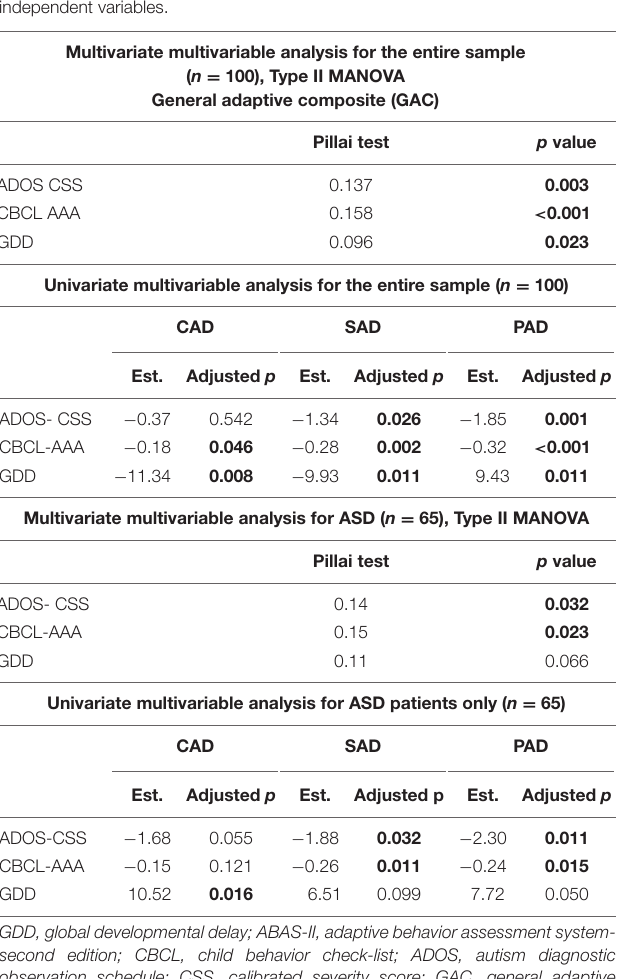
TABLE 3 | Multivariate and univariate multivariable analysis for the entire ( n = 100) and the ASD ( n = 65) sample, with ADOS-CSS, CBCL-AAA, and GDD as independent